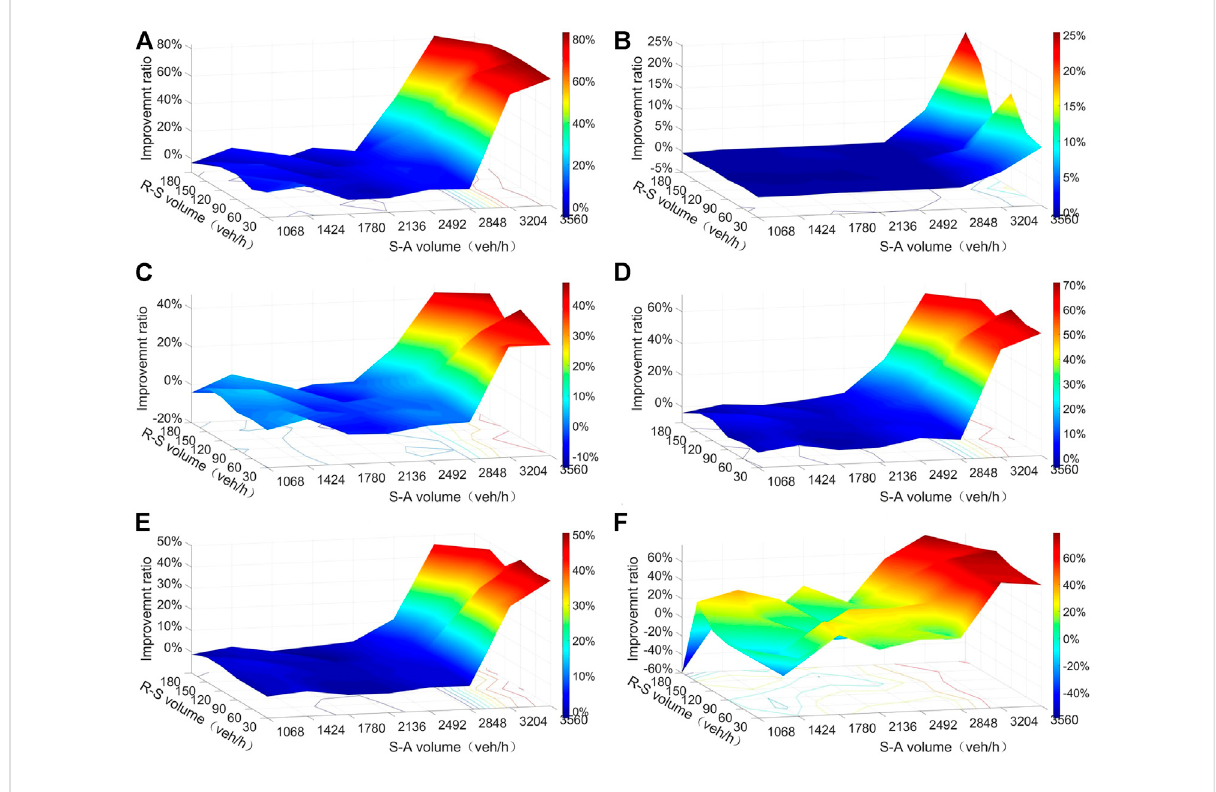
FIGURE 9 Improvement ratio of scheme4, compared with scheme1. (A) Queue length, (B) number of vehicles, (C) delay, (D) number of stops, (E) CO emissions, (F) number of con fl